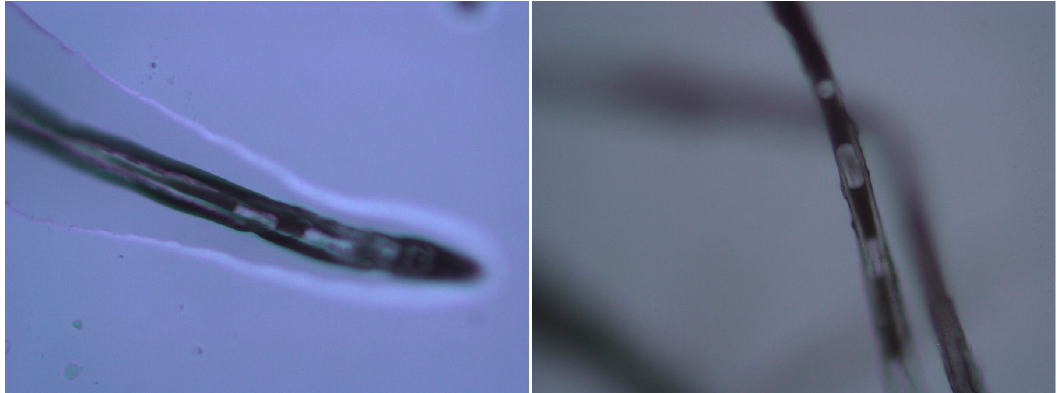
Figure 5. Microscopic images of BPCM into wood fibers.